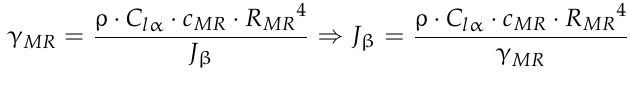
Figure 8. Rotor radius and solidity for a sizing example with DL = 400 N/m 2 , C T / σ = 0.08 and R MR ,max = 8 m for different m MTOM limit: R MR ,max = 8 m .